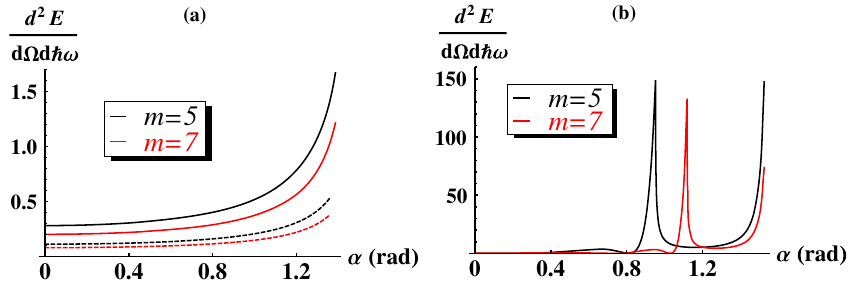
FIG. 9. The distribution of the radiation for fifth and seventh SPR peaks (diffraction orders) depending on α for (a) THz and optical and (b) x-ray frequency regions. The parameters are the same as in Fig. 7. It is taken into account that for radiation on the conical surface Eq. (43) is satisfied.